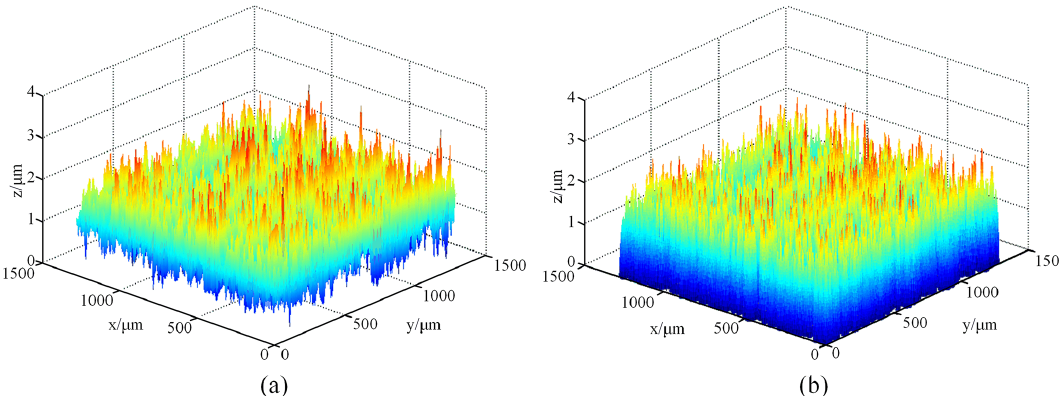
Figure 8. Typical 3D topographies of milling specimens. (a) Measured surface. (b) Watershed and fitted.